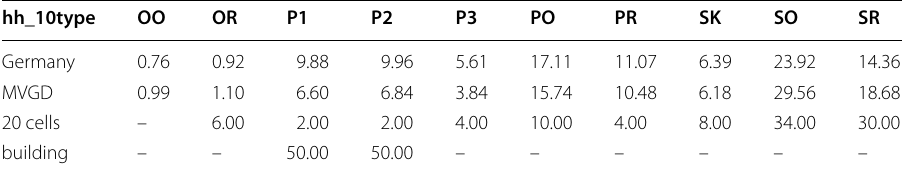
Table 5 HH distribution at different aggregation levels in % hh_10type